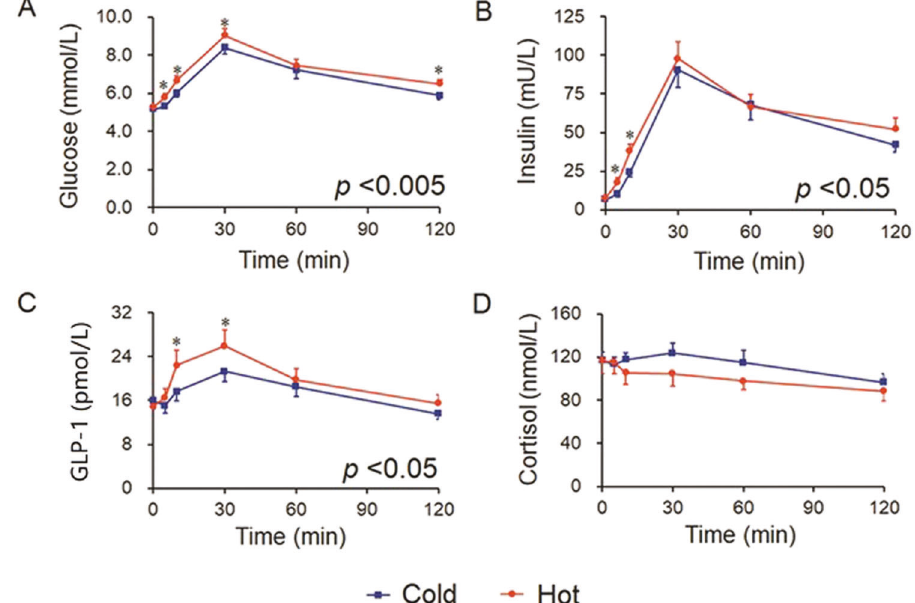
Fig. 1 The blood glucose and glucose-responsive hormone levels in cold and hot OGTTs in normal subjects. A Blood glucose, B insulin, C GLP-1, and D cortisol levels in OGTTs in normal subjects ( n = 19). Data were analyzed with ANOVA for repeated measurements, and all “ P ” values are from the ANOVA. If there was statistical signi fi cance between the two temperatures ( P < 0.05), this was followed with a Bonferroni test for speci fi c time points. Blue line = cold OGTT; red line = hot OGTT; * P < 0.05 in Bonferroni test. OGTT oral glucose-tolerance test, GLP-1 glucagon-like